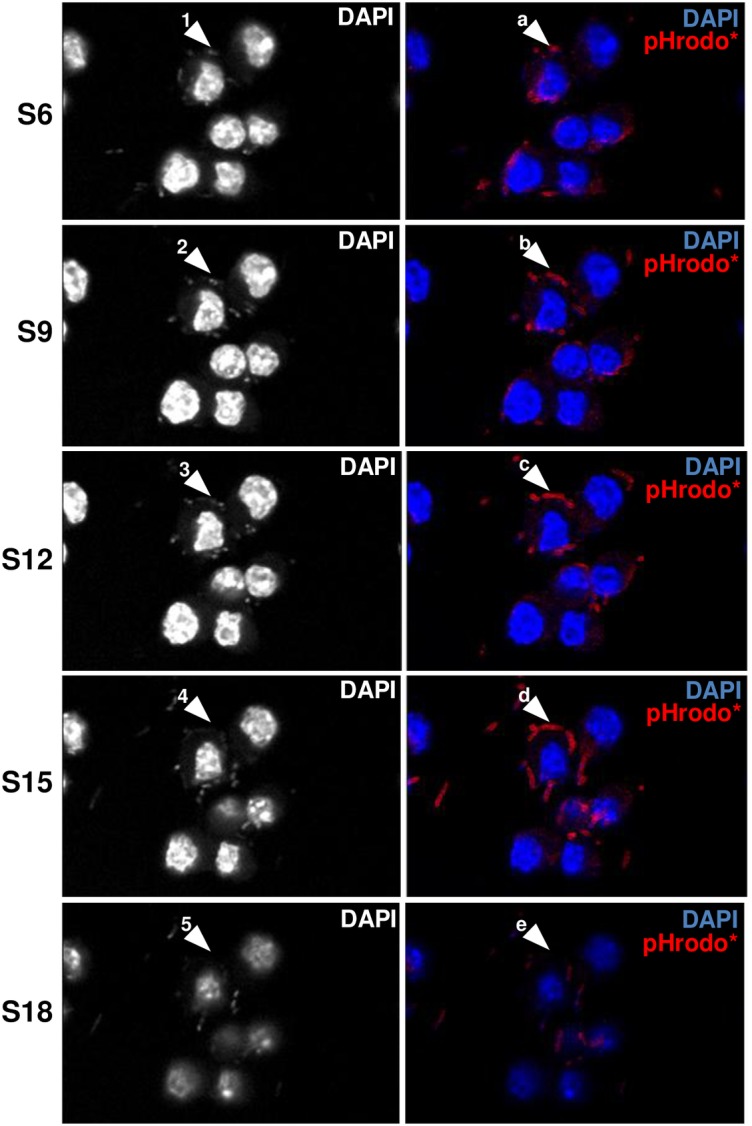
Surface-bound Yersinia is tightly enclosed in a low pH environment.RAW macrophages were infected with wild-type Y. pseudotuberculosis (pYV) for 40 minutes and then labeled with pHrodo as described in Fig 4 and then analyzed by laser scanning confocal microscopy. Shown are 5 representative planes of a series of 12 consecutive Z-stacks (S) in which each stack is 0.5μm from the subsequent slice. See main text for explanation of the indicated arrows.